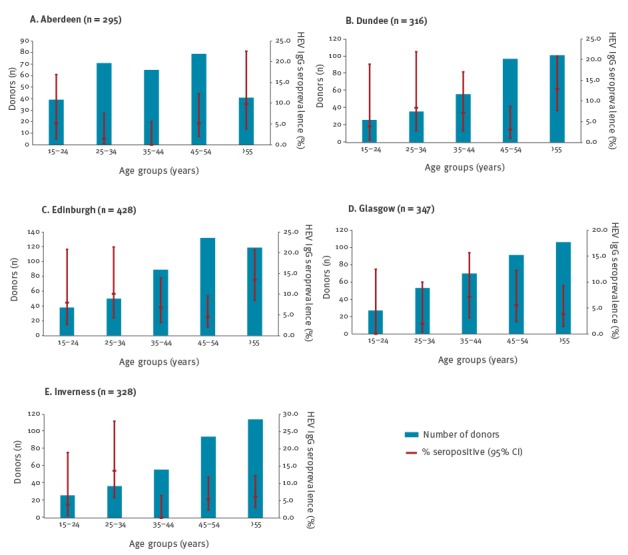
Anti-hepatitis E virus IgG seroprevalence in differing areas by age, Scotland, August 2014 to September 2015 (n=1,714)